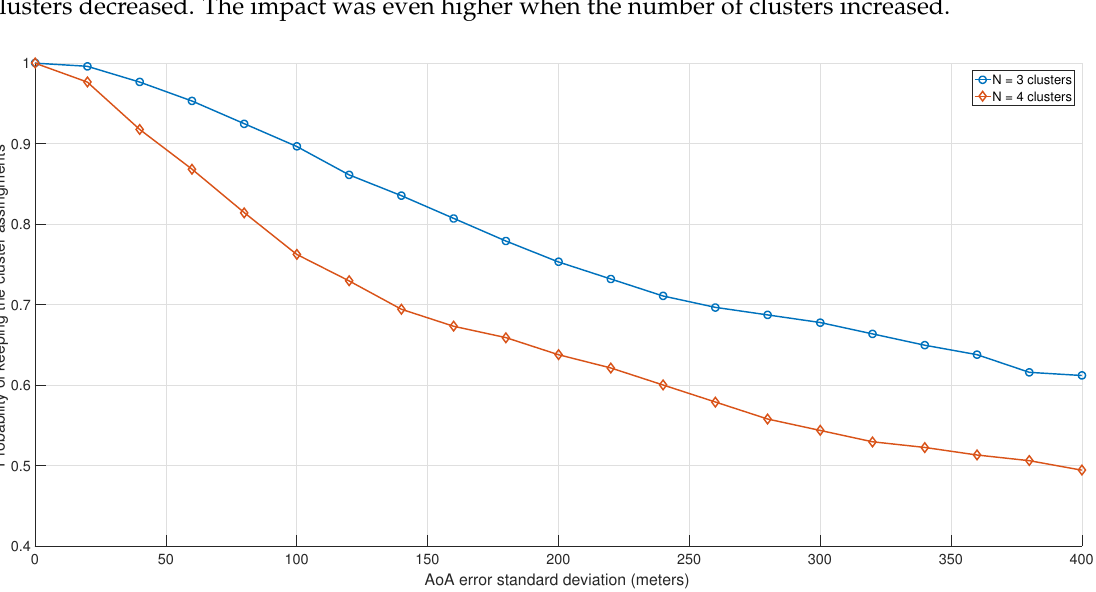
Figure 12. Probability of users keeping the same clusters, as a function of the AoA